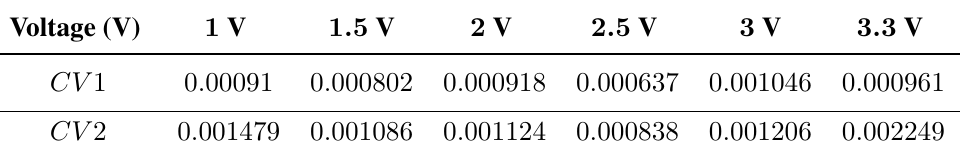
Table 1. The coefficient of variation at different